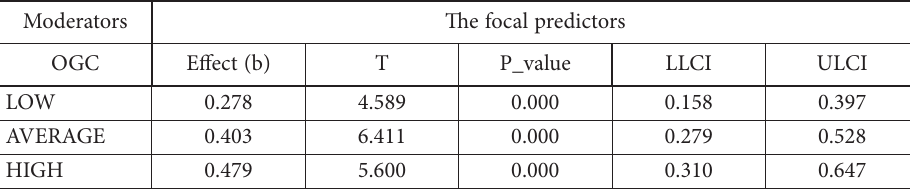
Table 5. Conditional effect at the values of OGC